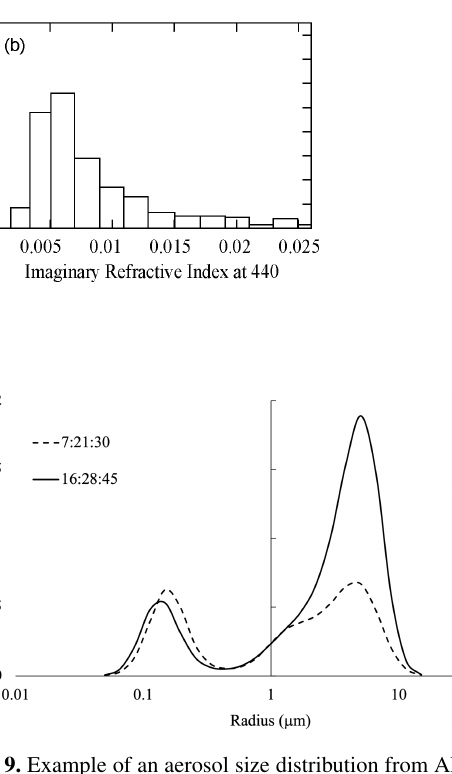
Figure 9. Example of an aerosol size distribution from AERONET with a change between two almucantar procedures occurring be- tween the early-morning and late-afternoon observations (data ac- quired at the Aubiere site in July